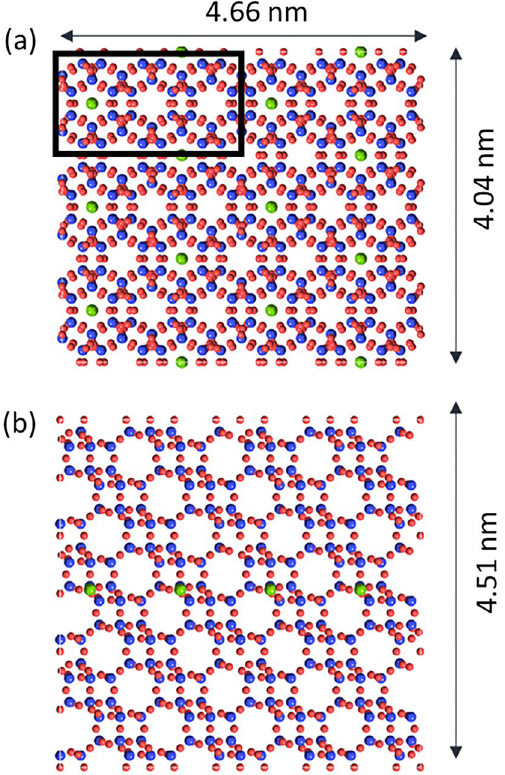
Figure 1. Supercell used for ptychographic image simulation viewed from the ( a ) x–y and ( b ) y – z directions. Cu, Si, and O atoms are green, blue, and red, respectively. The black rectangle in ( a ) contains a six-membered- ring column with Cu (left) and two six-membered-ring columns without Cu (center and right).